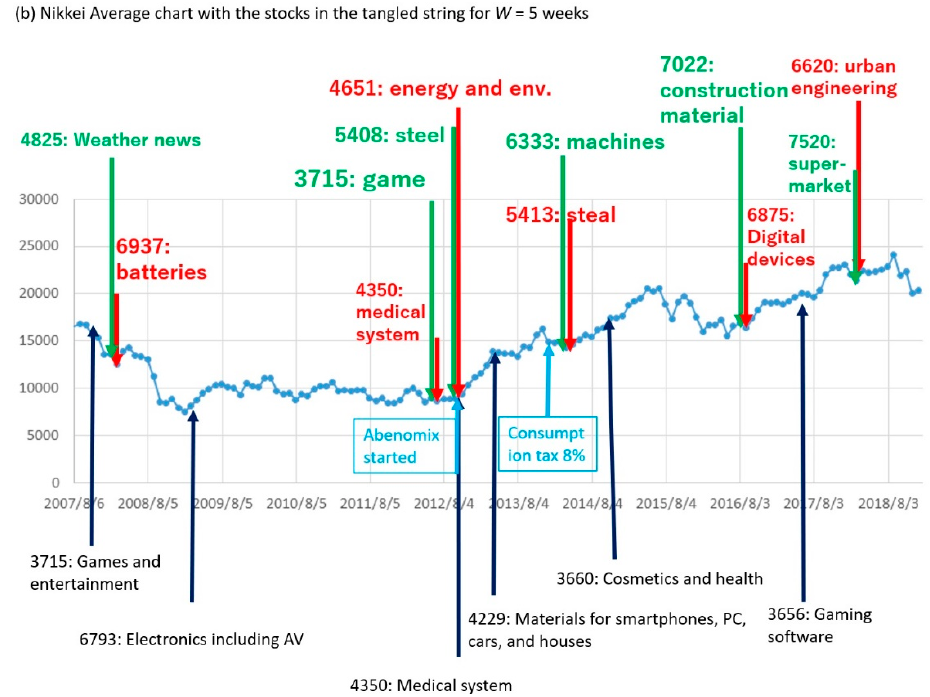
Figure 5. Result of TS for W = 5 (weeks) for the top-10 data. ( a ) and ( b ) mean the same as in Figure 4, respectively.